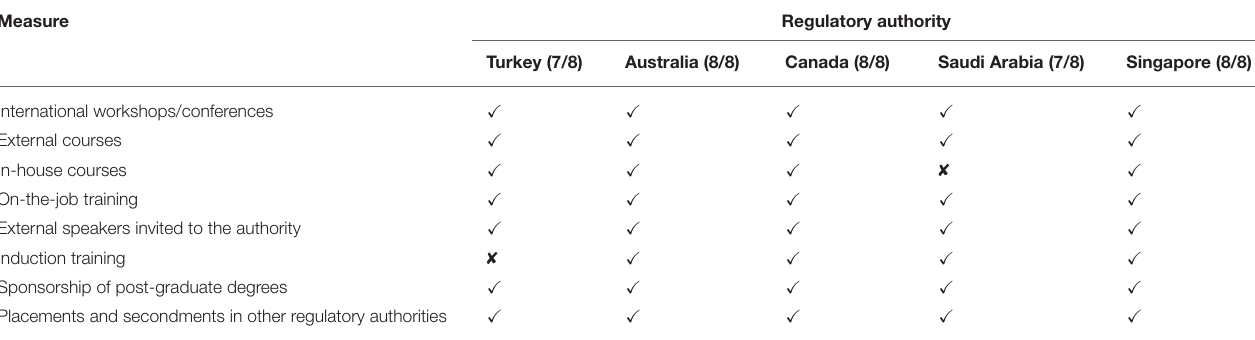
TABLE 5 | Training and education in the five